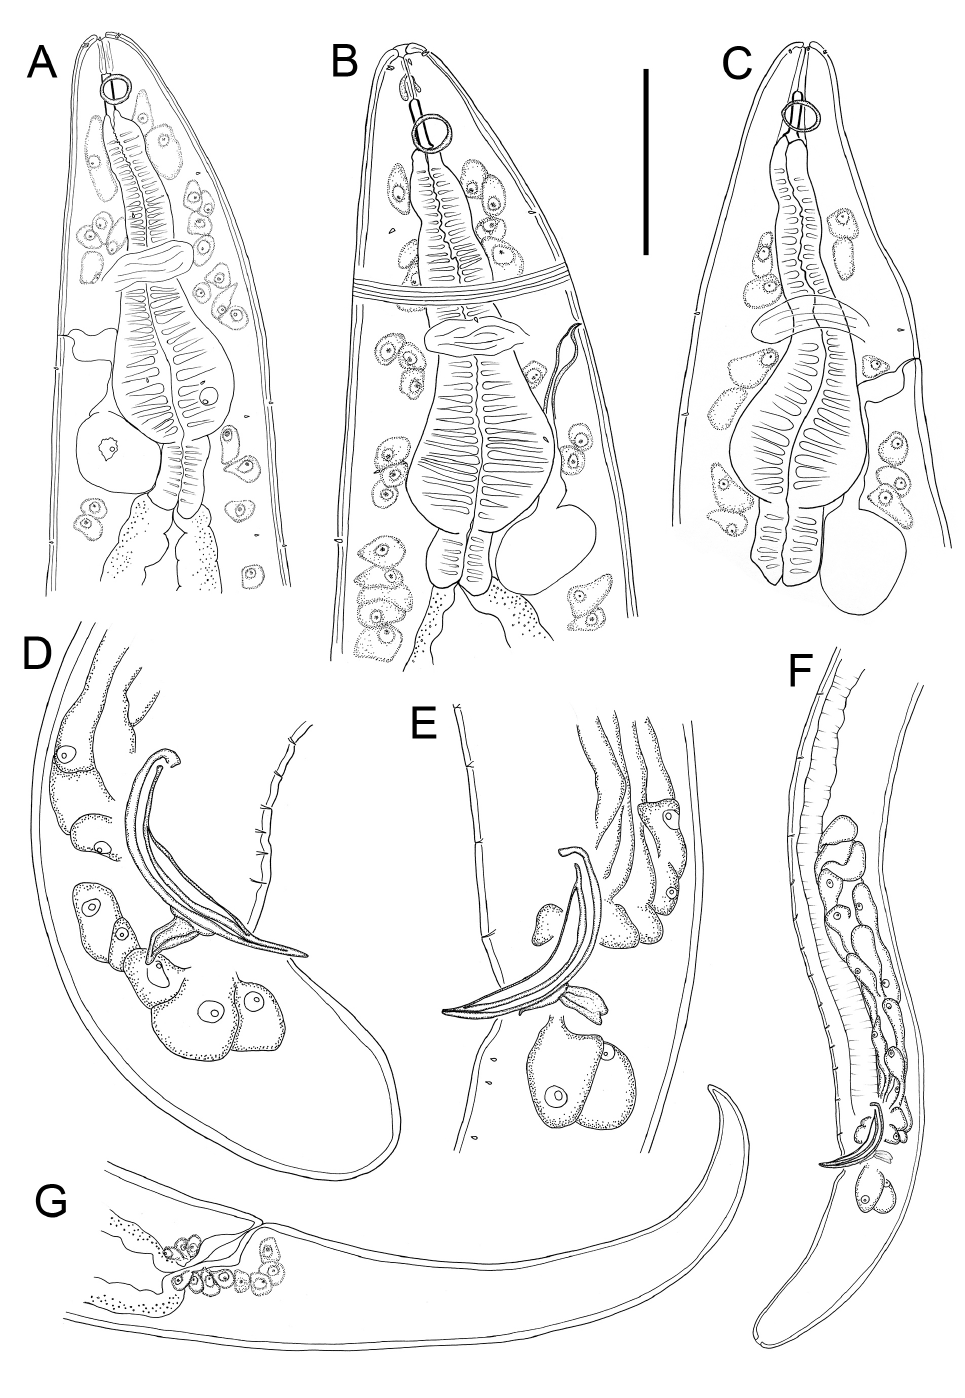
Fig. 7. Aulostomonema abyssum gen. et sp. nov. A , E – F . Holotype (NIWA154911). B , D . Paratype (NIWA154912). C , G . Paratype (NIWA154913). A – B . Anterior body portion of male. C . Anterior body region of juvenile. D . Posterior body region of male. E . Copulatory apparatus. F . Posterior body region of male. G . Posterior body region of juvenile. Scale bar: A = 100 µm; B, D, G = 75 µm; C = 70 µm; E = 80 µm; F = 200